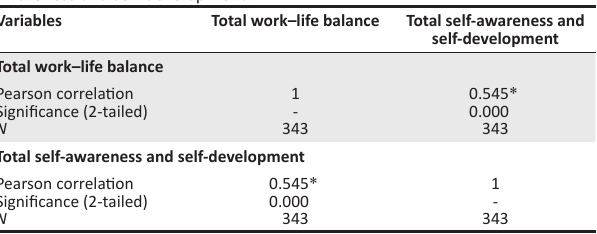
TABLE 7: Pearson correlation coefficients – Work–life balance as well as self- awareness and self-development.